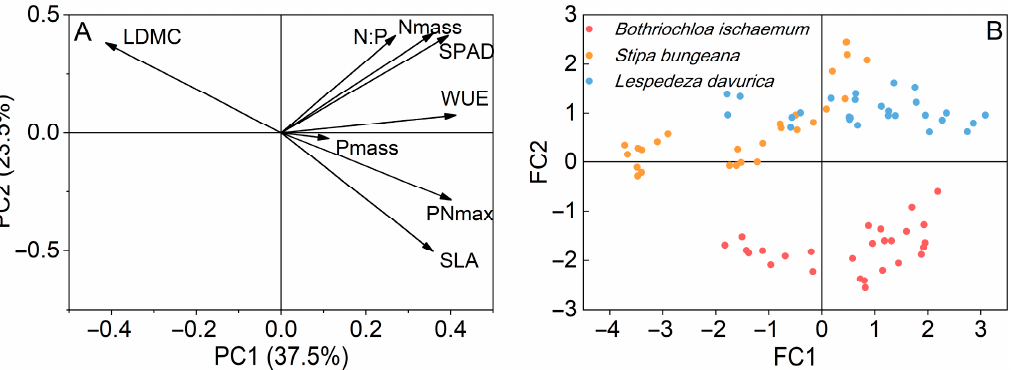
Figure 8. Principal component analysis (PCA) of photosynthetic characteristics ( P Nmax and WUE) and leaf functional traits (SPAD, N mass , P mass , SLA, and LDMC) in the three species under N and P additions. ( A ) Loadings for each leaf trait; ( B ) Factor scores for each species.